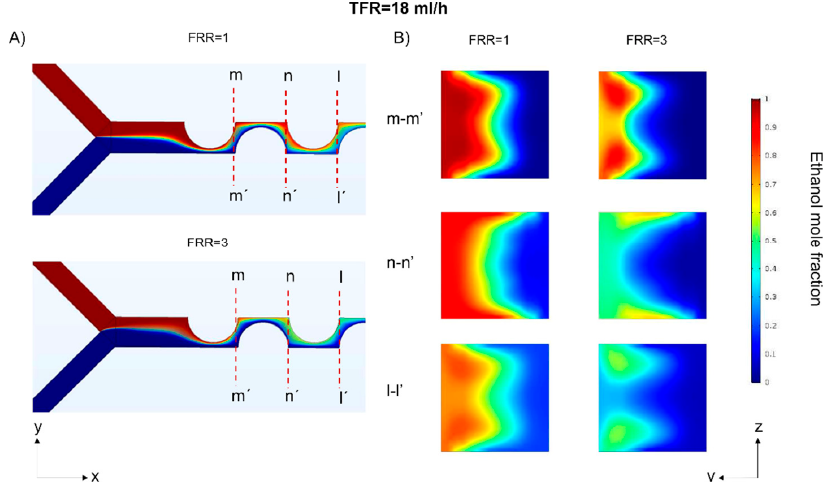
Figure 9. Numerical simulations comparing the concentration profiles at FRR = 1 and FRR = 3 at a constant TFR = 18 mL/h. ( A ) Upper view of the mixing channels and position of the cross ‐ sections. ( B ) Cross ‐ sections at different FRRs.